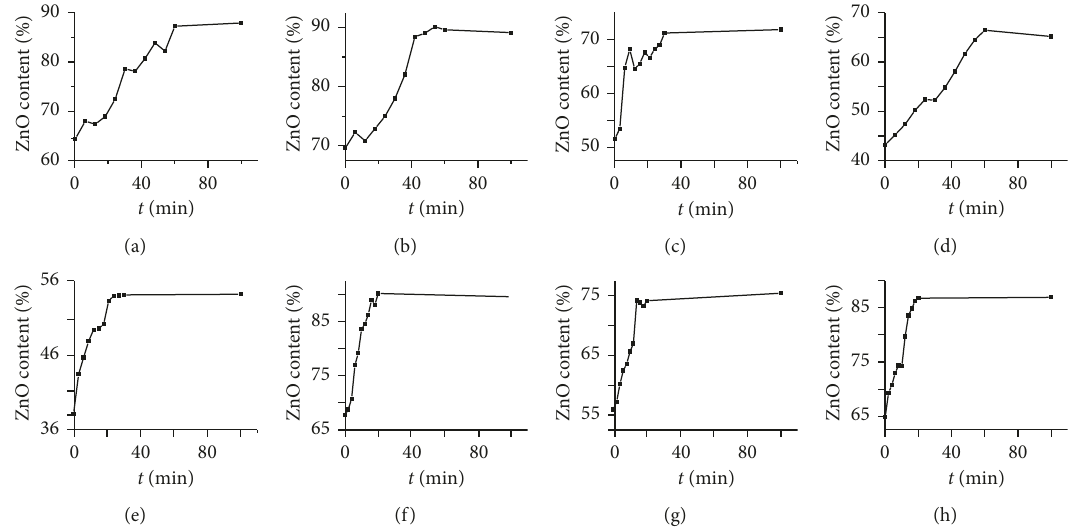
Figure 2: Change of ZnO content of 8 batches of calamine samples during calcination. (a) S1. (b) S2. (c) S3. (d) S4. (e) S5. (f) S6. (g) S7. (h) S8.